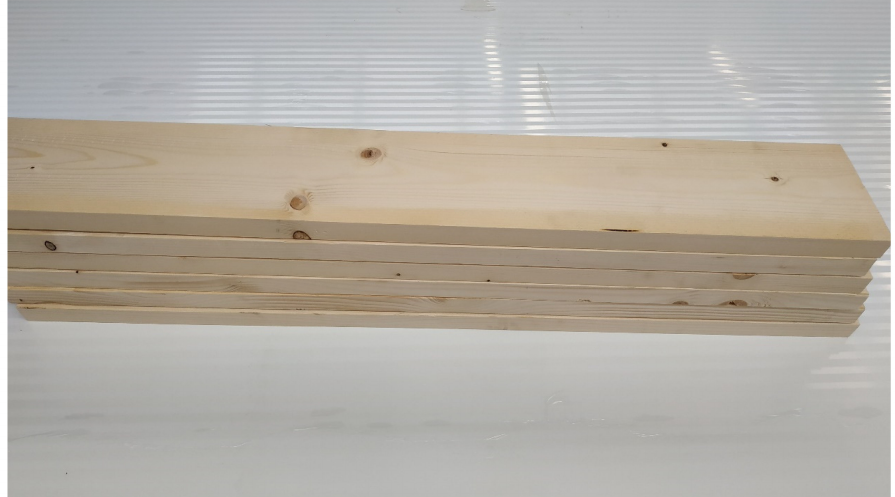
Figure 4. The elements of spruce wood before trimming to 20 × 20 × 300